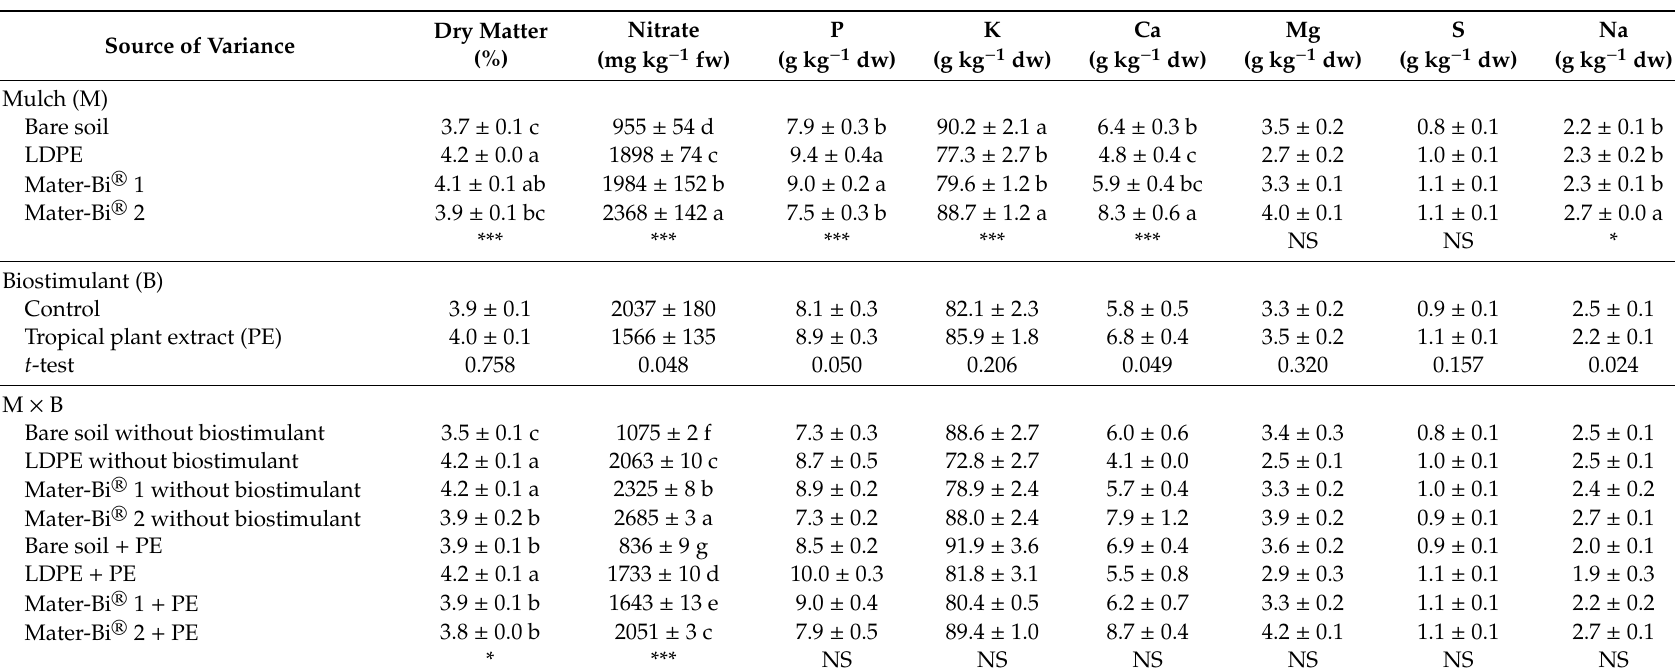
Table 3. Mean comparison and analysis of variance for leaf dry matter percentage and mineral composition of untreated and biostimulant-treated greenhouse lettuce grown under LDPE mulch and biodegradable (Mater-Bi ® 1 and Mater-Bi ® 2) mulching materials in relation to bare